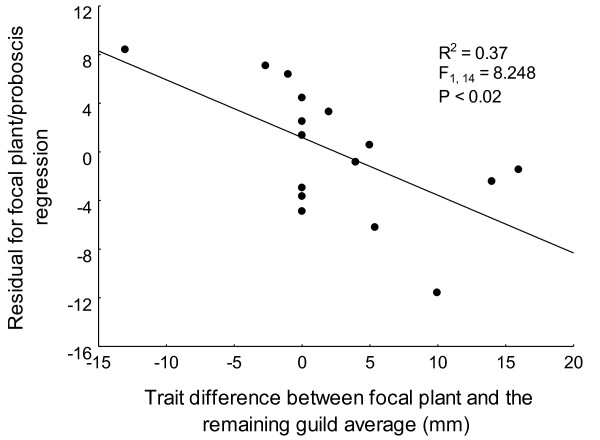
The effect of community composition on trait-matching. The negative OLS regression between trait mismatching and community heterogeneity. Community heterogeneity was measured as the mean difference in corolla length between a single focal plant (Zaluzianskya microsiphon) and other food sources found at the site. Trait mismatching was calculated from the residuals of the regression between pollinator (Prosoeca ganglbaueri, Y-axis) proboscis length and the corolla tube length of its most important and widespread host plant (Zaluzianskya microsiphon, X-axis). Negative residuals (Y-axis), indicate that fly proboscis length is shorter than predicted by the plant-proboscis regression. Negative values on the X-axis indicate Zaluzianskya has smaller tube lengths than the guild average.